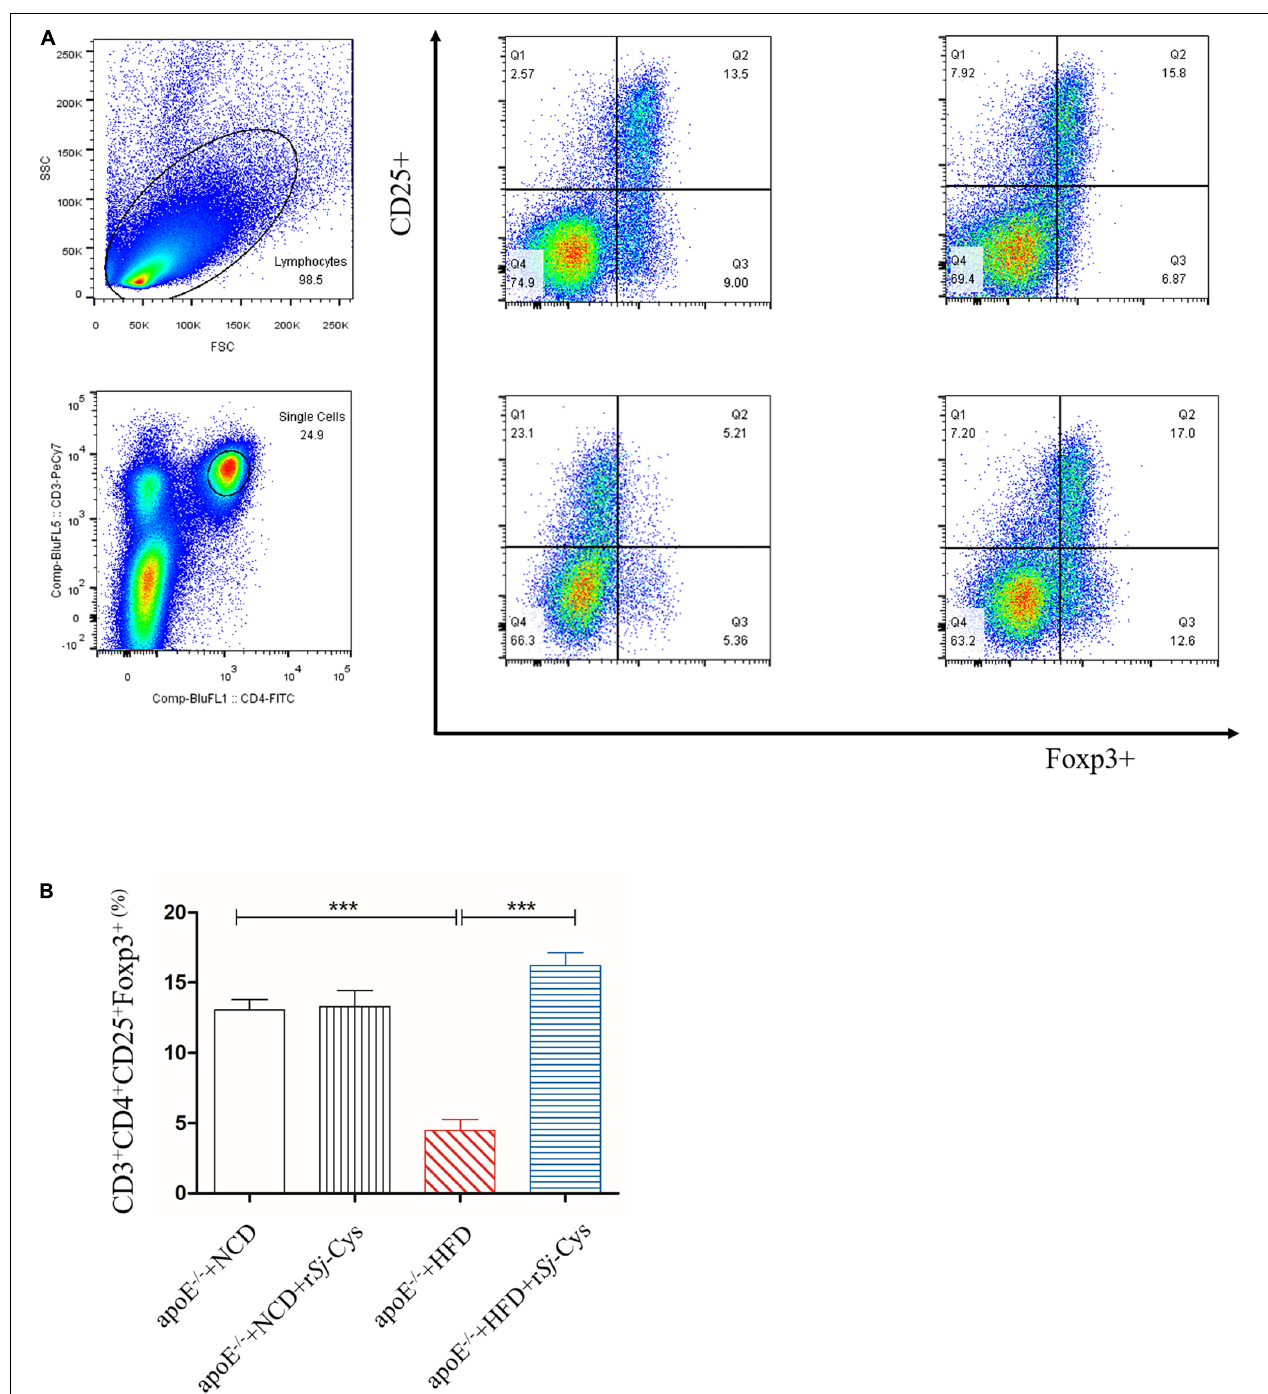
FIGURE 11 | (A) Representative data from the FACS analysis of the CD3 + CD4 + CD25 + Foxp3 + Tregs and the numbers in the upper right quadrants indicate the positive percentages of Tregs. (B) The corresponding bar graphs of the percentage of CD3 + CD4 + CD25 + Foxp3 + Tregs. The results are shown as the mean ± SEM for each group ( n = 6). *** P <